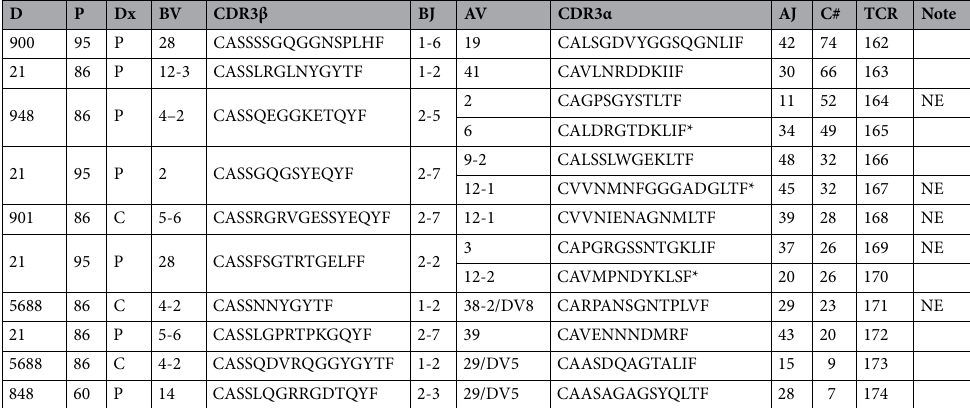
Table 3. Enriched TCRαβ from RFX4 antigen specific CD4+ CD8− T cells. D donor, P peptide, Dx diagnosis, C control, P patient, C# cell count, NE not expressed. *Alternative